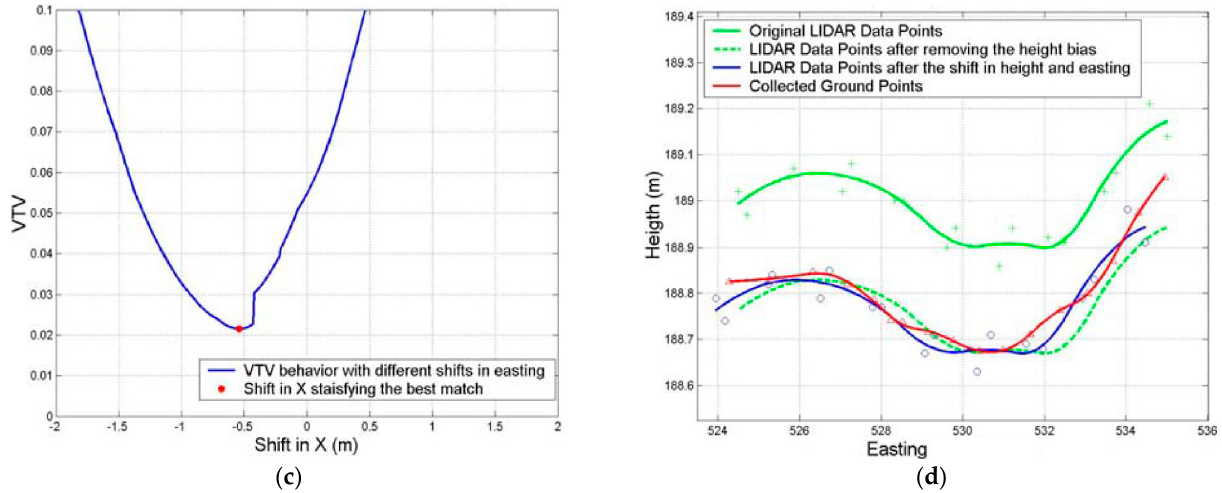
Figure 9. ( a–d ) Planimetric offset in Easting (X) direction at location A.